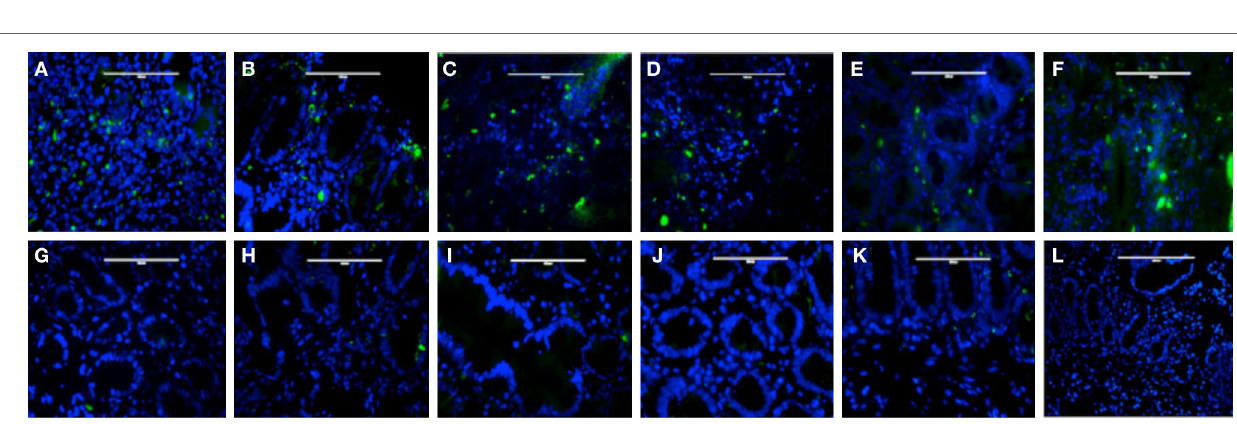
FigUre 1 | (a) Flow cytometry was used to evaluate circulating plasmacytoid dendritic cells (pDCs) in HIV/AIDS cases and controls. Aliquots of whole blood from 23 cases and 16 controls were labeled with APC-anti-CD303, PE-anti-CD123, and PerCp-anti-CD45. Lymphocytes were initially gated by CD45 + /side scatter and pDCs were identified as CD303 + /CD123 + lymphocytes. (B) pDCs, as a percentage of total lymphocytes, were used to evaluate differences between cases and controls. Mean pDC counts of HIV cases were 0.044 ± 0.084 and controls were 0.093 ± 0.014 ( p =